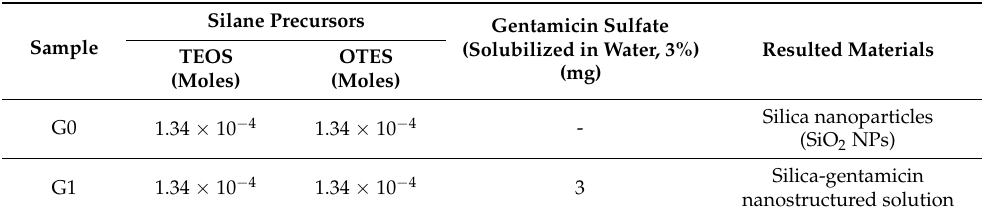
Table 1. Materials used for synthesis of: silica nanoparticles (SiO 2 NPs) and silica-gentamicin nanostructured